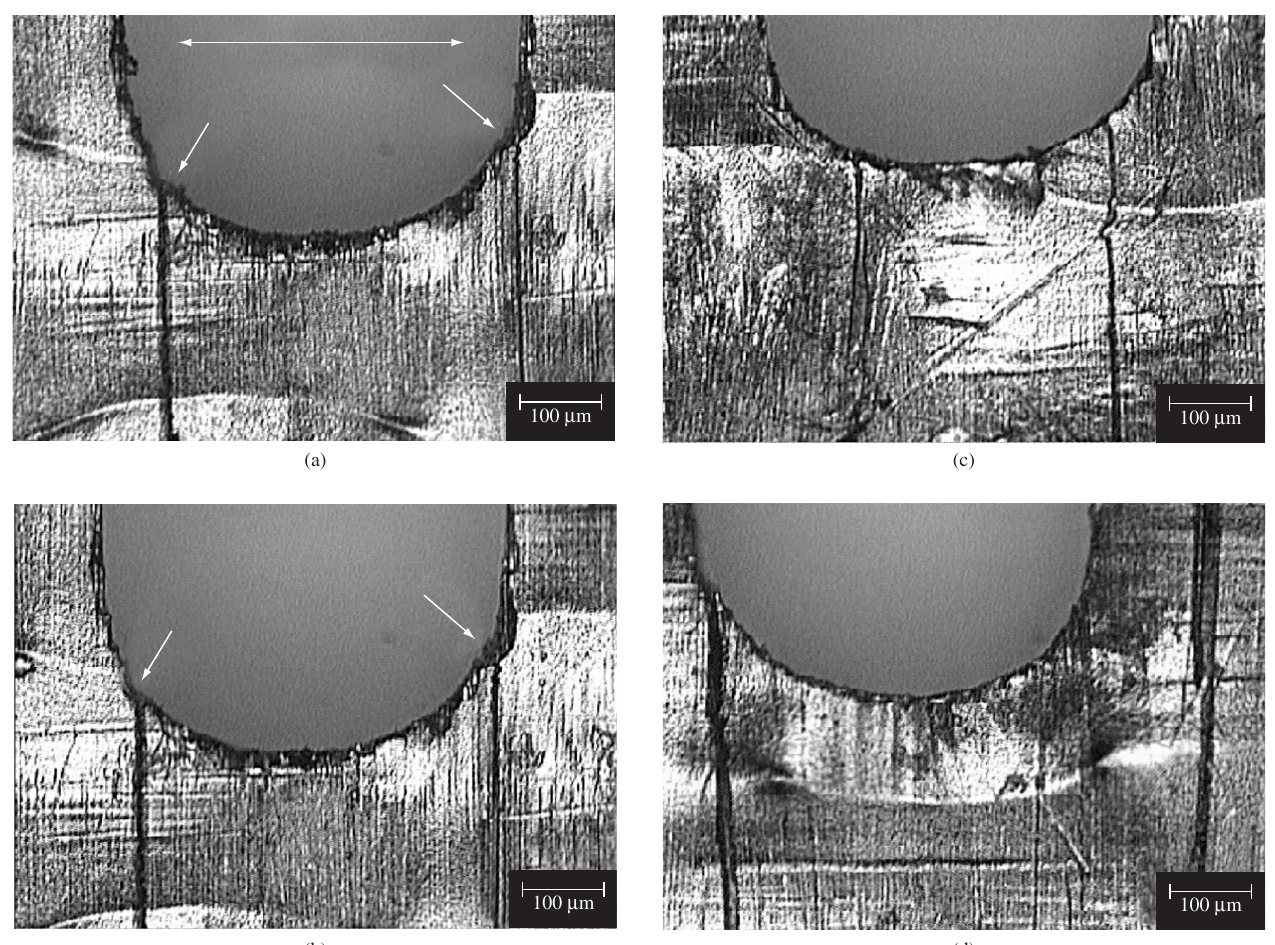
Figure 4. Fatigue damage externally developed at the notch tip location of laminates TP180, in two successive stages of cyclic loading: a, b) Specimen A, loading frequency of 5 Hz; c) Front and d) Back side of specimen C, frequency of 50 Hz.